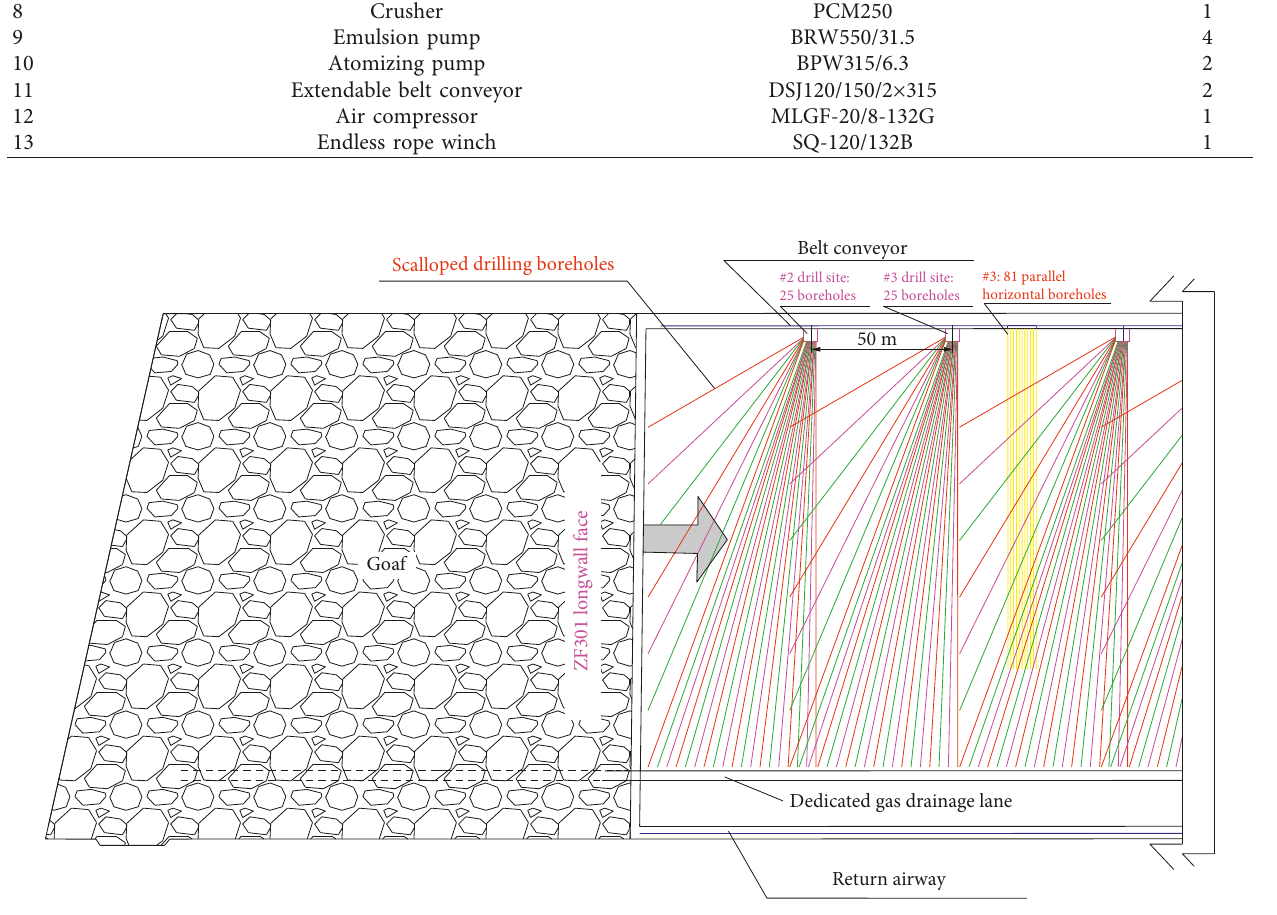
Figure 2: Gas drainage borehole layout in the working